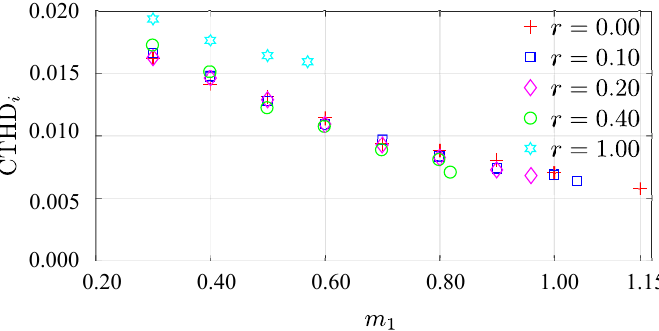
Figure 8. compound total harmonic distortion (CTHD v ) for different operation points within the linear modulation region.